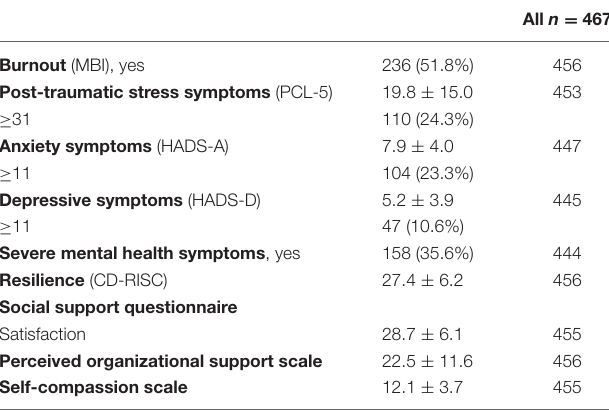
TABLE 2 | Psychological questionnaire scores of participants.